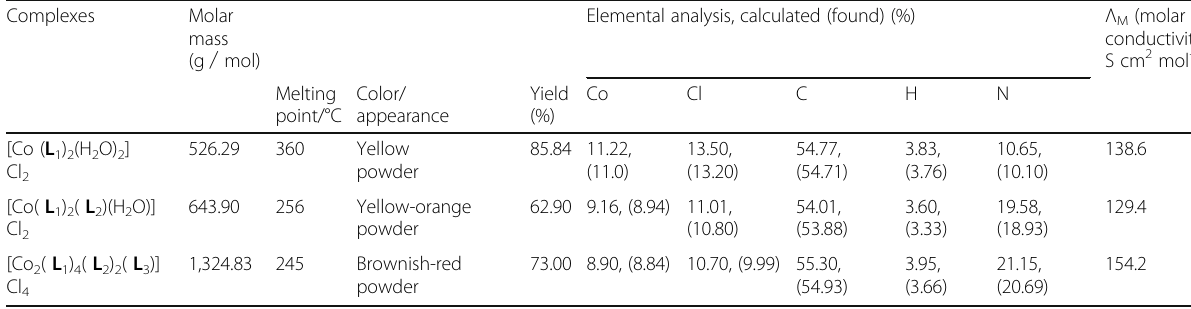
Table 1 Analytical data of the complexes Complexes